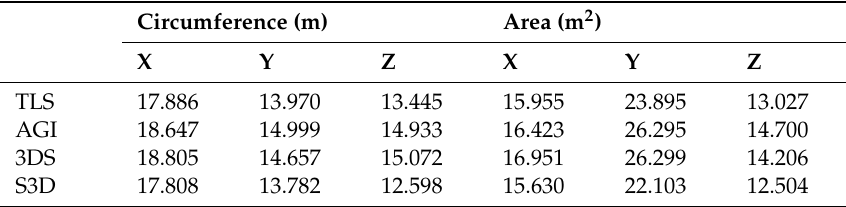
Table 9. Boulder No. 2: circumference and the section area